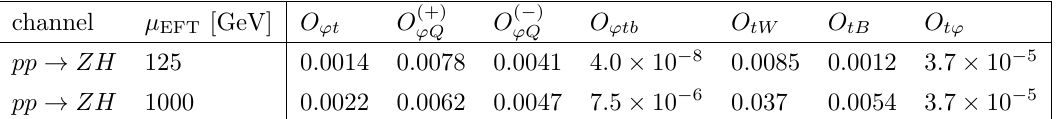
Table 7 . Percentage deviation at